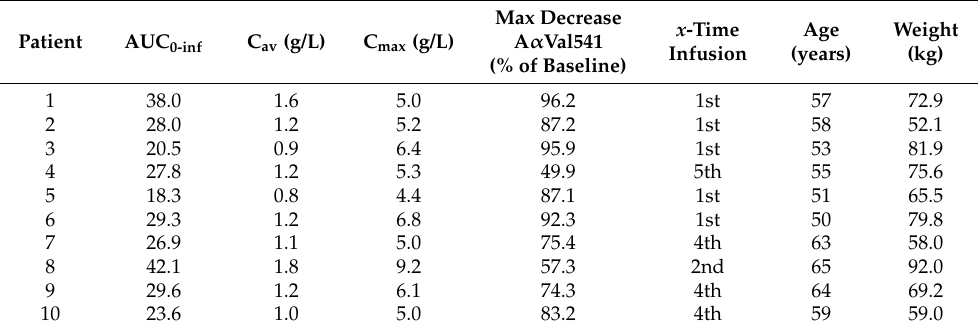
Table 2. Estimated pharmacokinetic parameters of the two-compartment population pharmacokinetic model of a single dose of 240 mg/kg AAT. Parameter Value CL (L/day) 0.605 V central (L) 3.14 Q (L/day) 2.11 V peripheral (L) 3.09 Inter-individual variability CL (CV%) 23.4 Inter-individual variability V central (CV%) 42.4 Inter-individual variability Q (CV%) 118.4